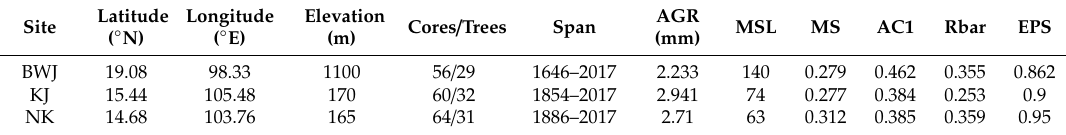
Table 1. Characteristics of study sites and chronology statistics calculated from the whole chronology length in the three di ff erent sites in Thailand. AGR, average radial growth rate; MSL, mean segment length; MS, mean sensitivity; AC1, first-order autocorrelation; Rbar, mean inter-series correlation;